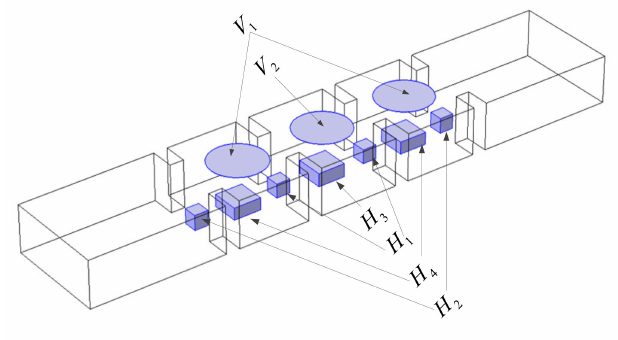
Figure 7. Structure of the three-pole waveguide filter.